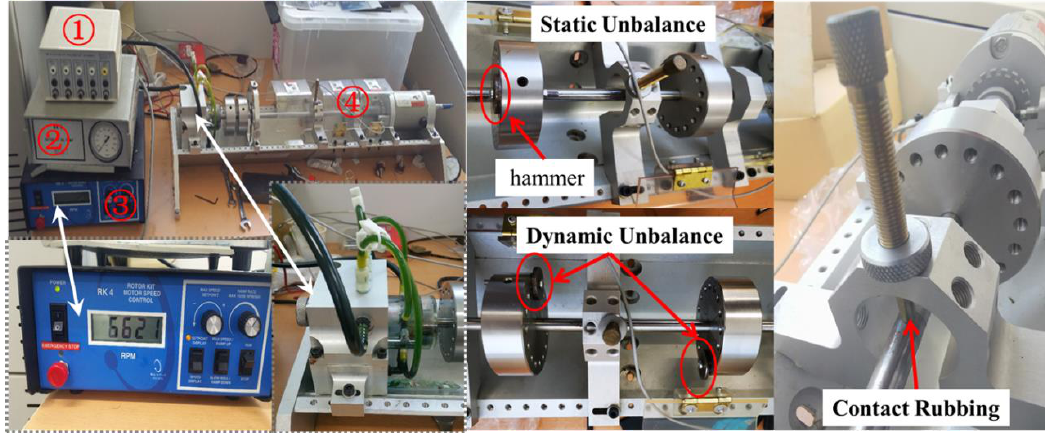
Figure 7. Experimental platform of sliding bearing.